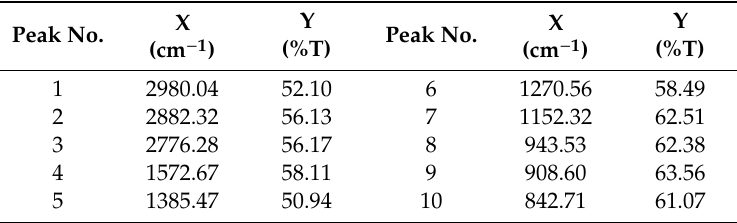
Table 3. Fourier-transform-infrared (FTIR) spectrometric analysis of PbTe samples of sample A5. Peak No.